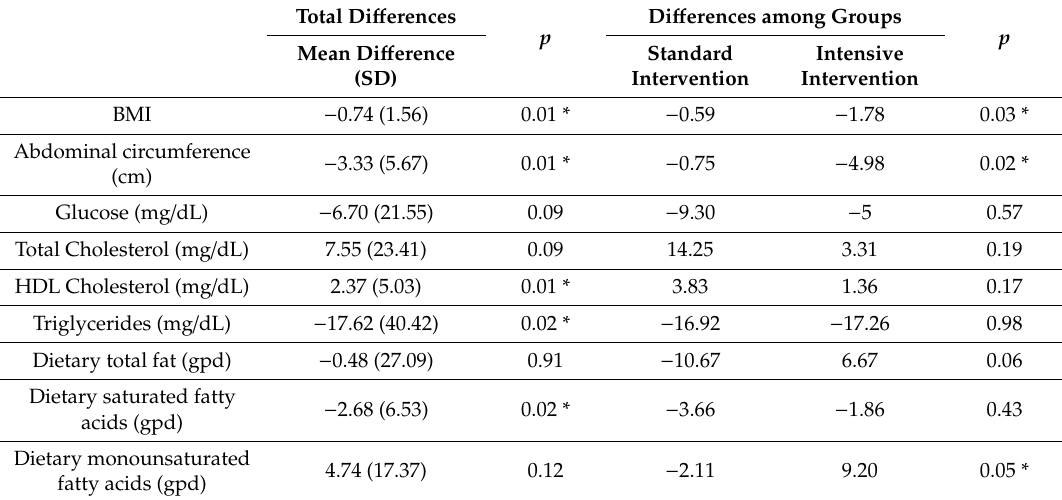
Table 2. Anthropometrics and diet parameters after